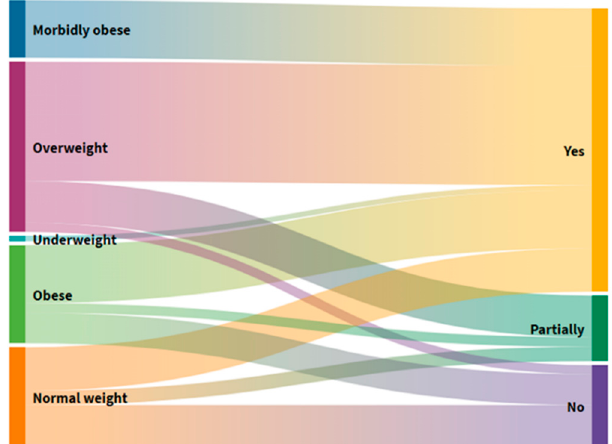
Figure 11. Alluvial diagram of the distribution of users according to the BMI groups and physical activity (alone or with the